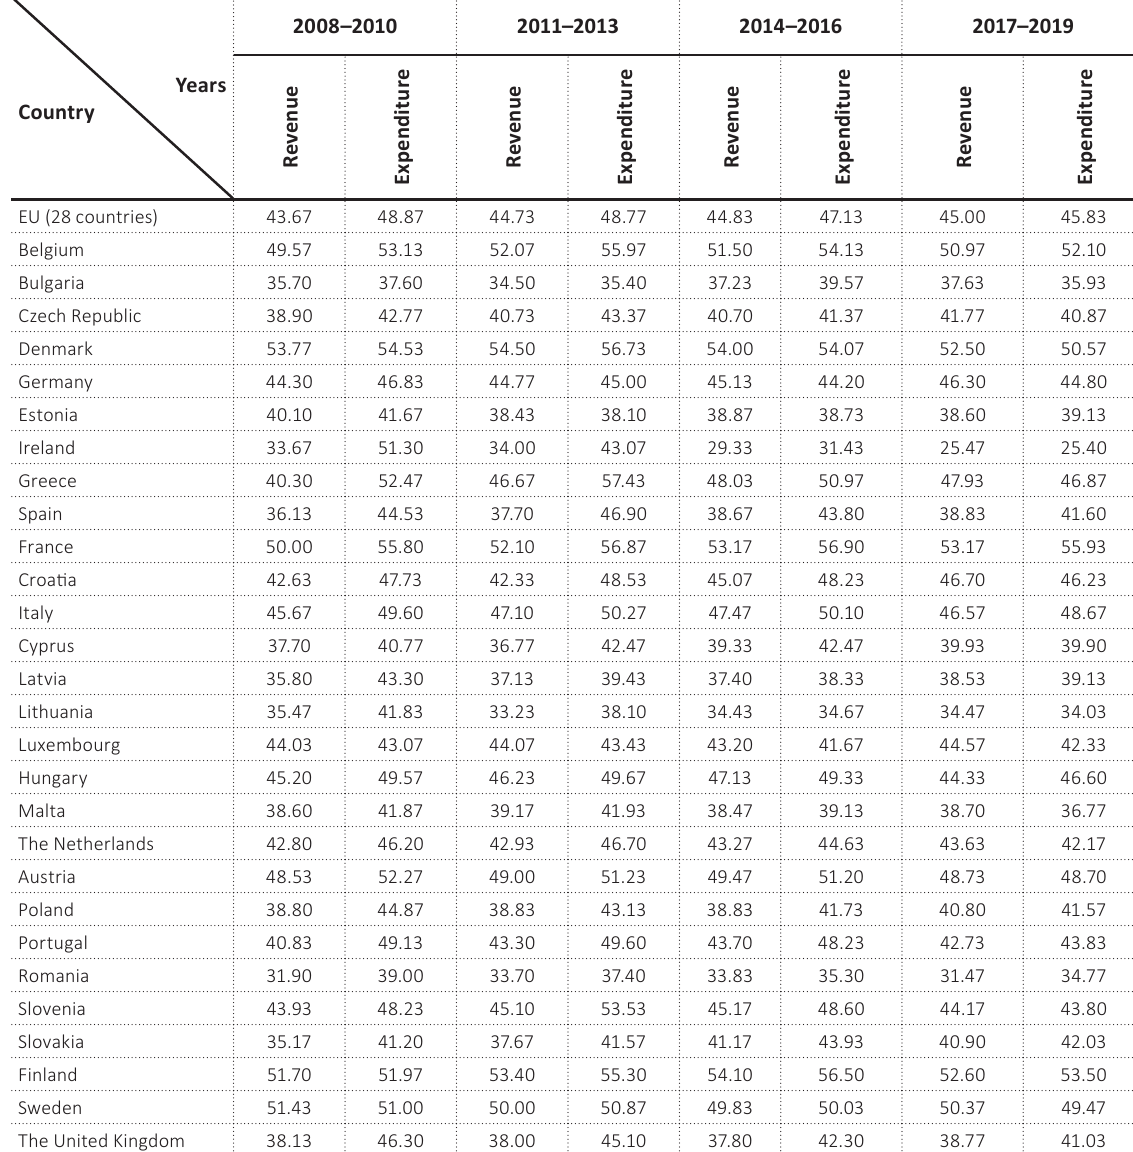
Source: Based on the data from